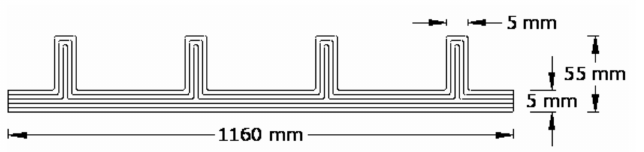
Figure 3. Layup structure of GFRP-stiffened composite plate (not to scale).